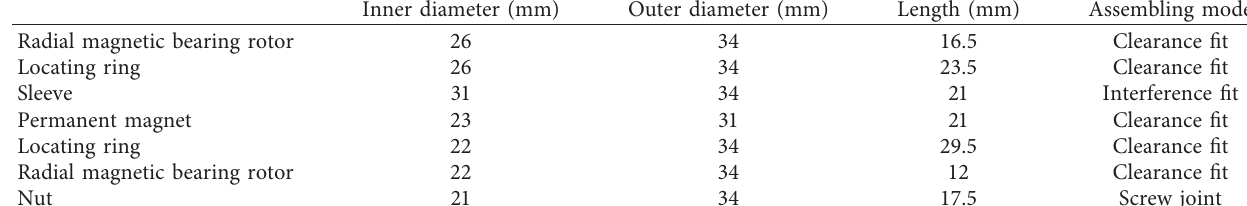
Table 4: The parameters and assembling modes of the rotor assembly.